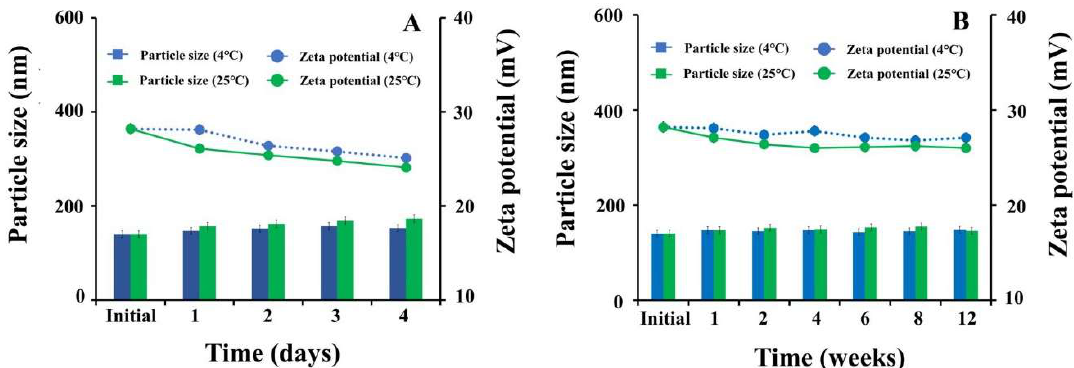
Figure 9. In vitro protein (BSA) binding onto the ( A ) CSO-SPIONs; PEG-CSO-SPIONs; CG-PEG-CSO-SPIONs, and ( B ) a representative TEM image of the CG-PEG-CSO-SPIONs before and after incubation with the BSA solution.